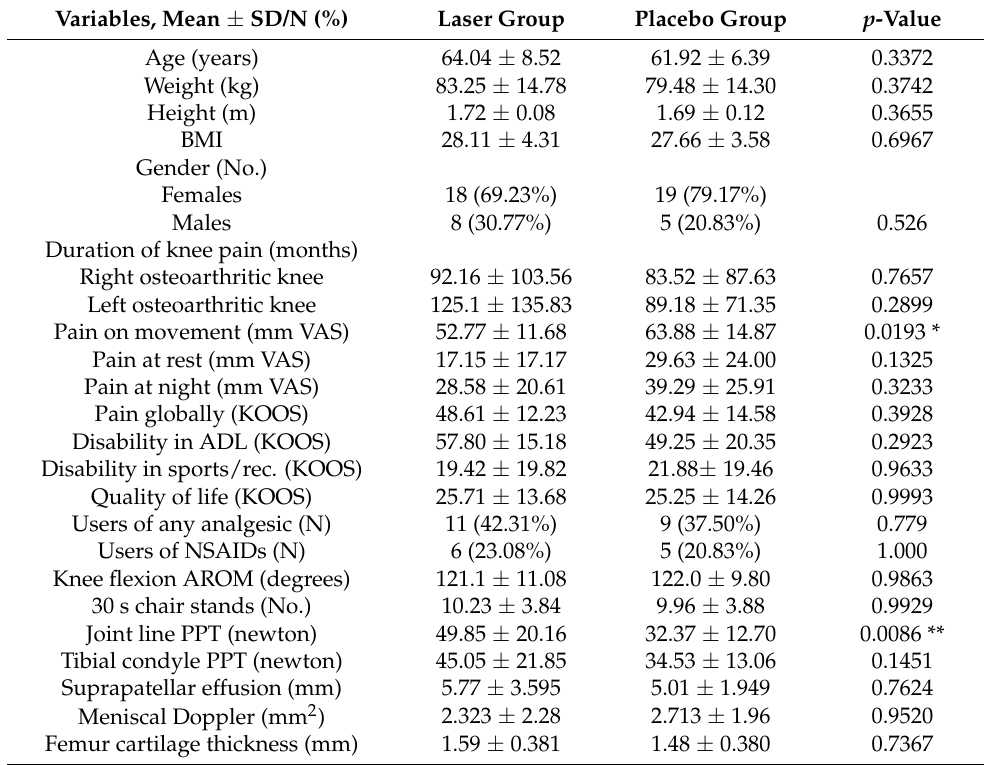
Table 1. Baseline characteristics of the participants in both groups.